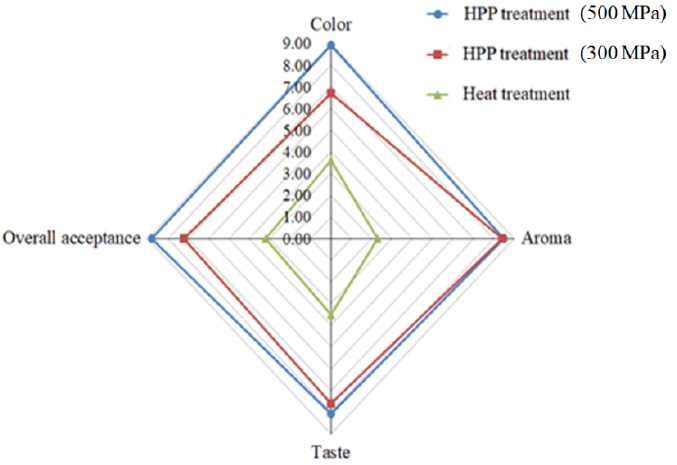
Figure 7. Sensory properties of L. acidophilus BCRC14079-fermented mango jam.